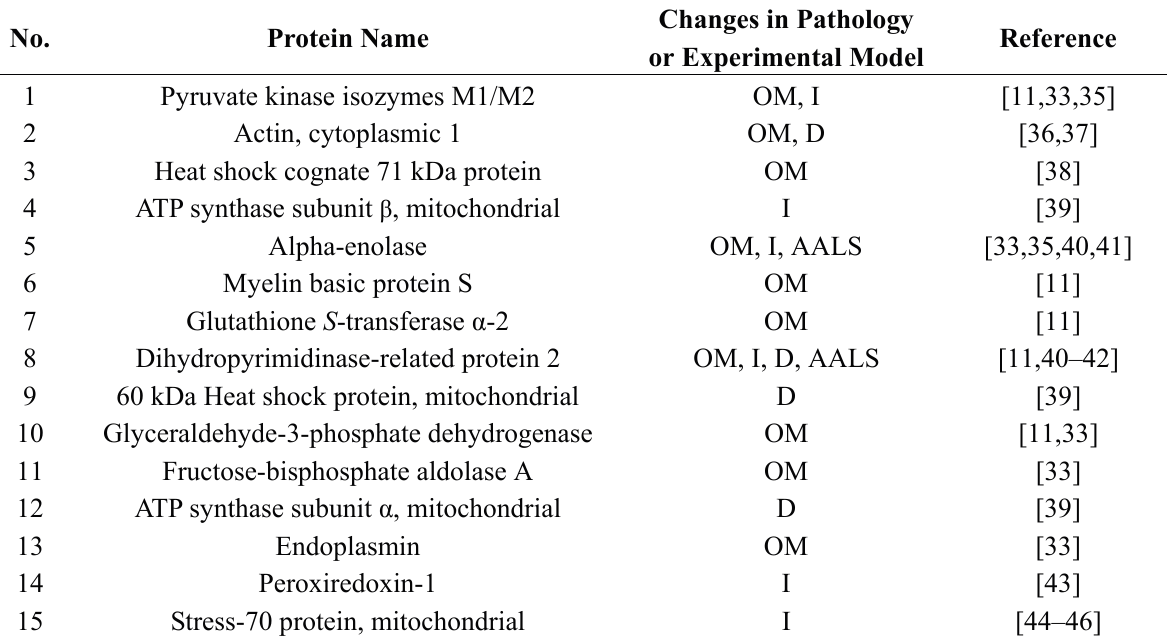
Figure 1. Subdivision of amyloid-binding proteins identified in brain homogenates by their functions: Numbers indicate total number of proteins in each group and numbers in parentheses show the percentage of the total number of identified proteins. Table 1. Amyloid-binding proteins altered or oxidatively modified in Alzheimer’s disease and related pathologies and their experimental